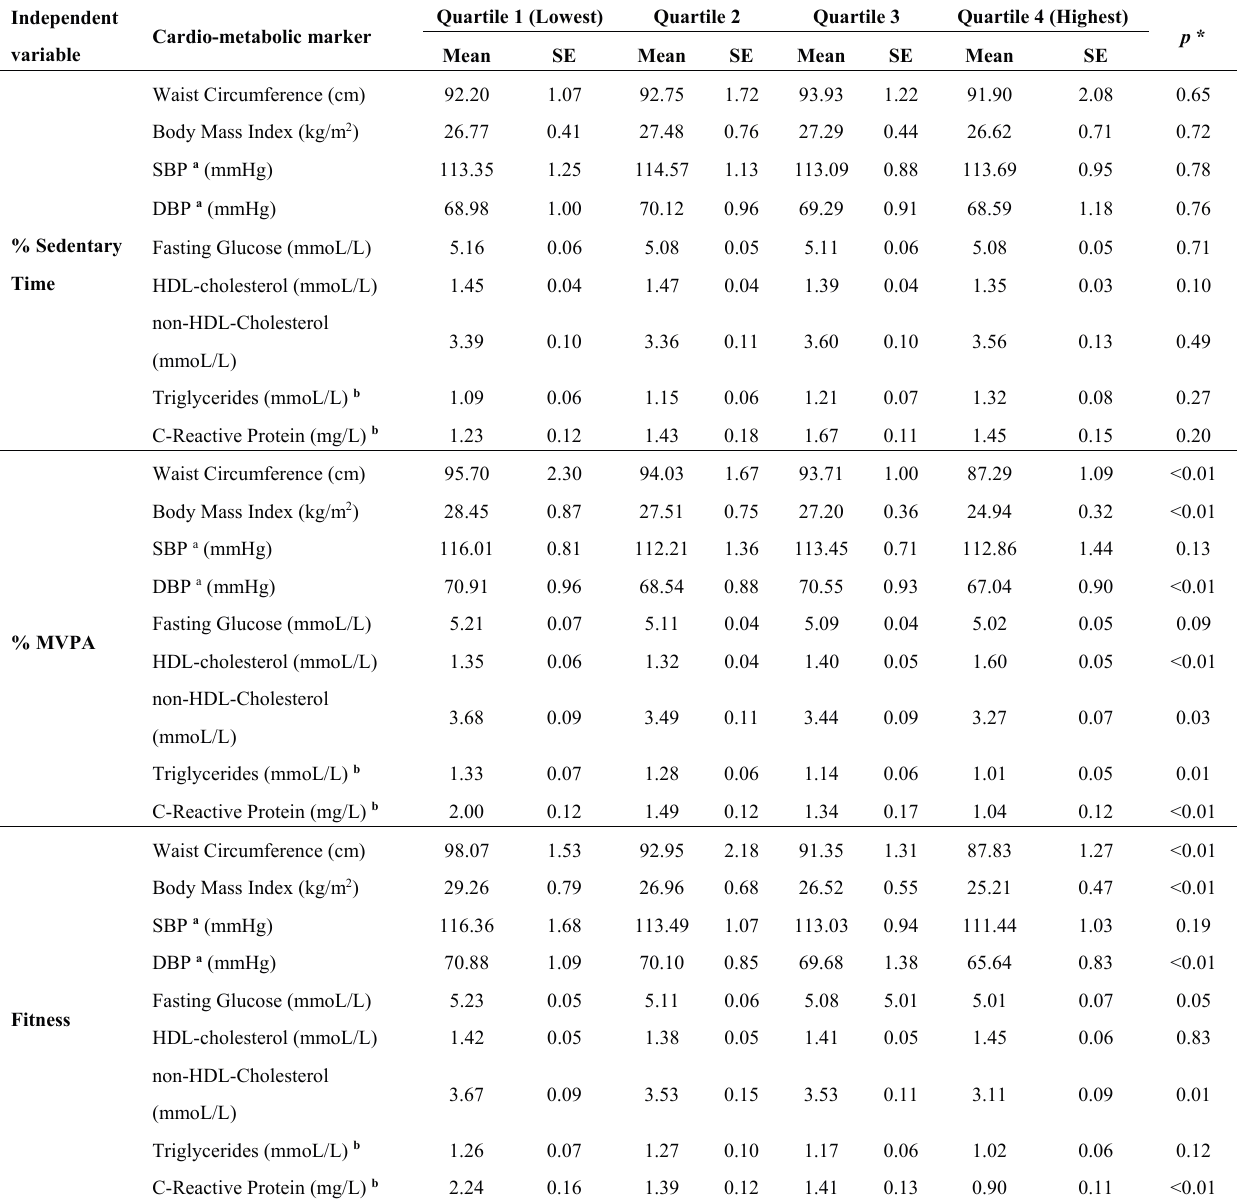
Table 2. Cardio-metabolic markers according to quartiles of sedentary time, MVPA, and fitness. Independent Cardio-metabolic marker variable